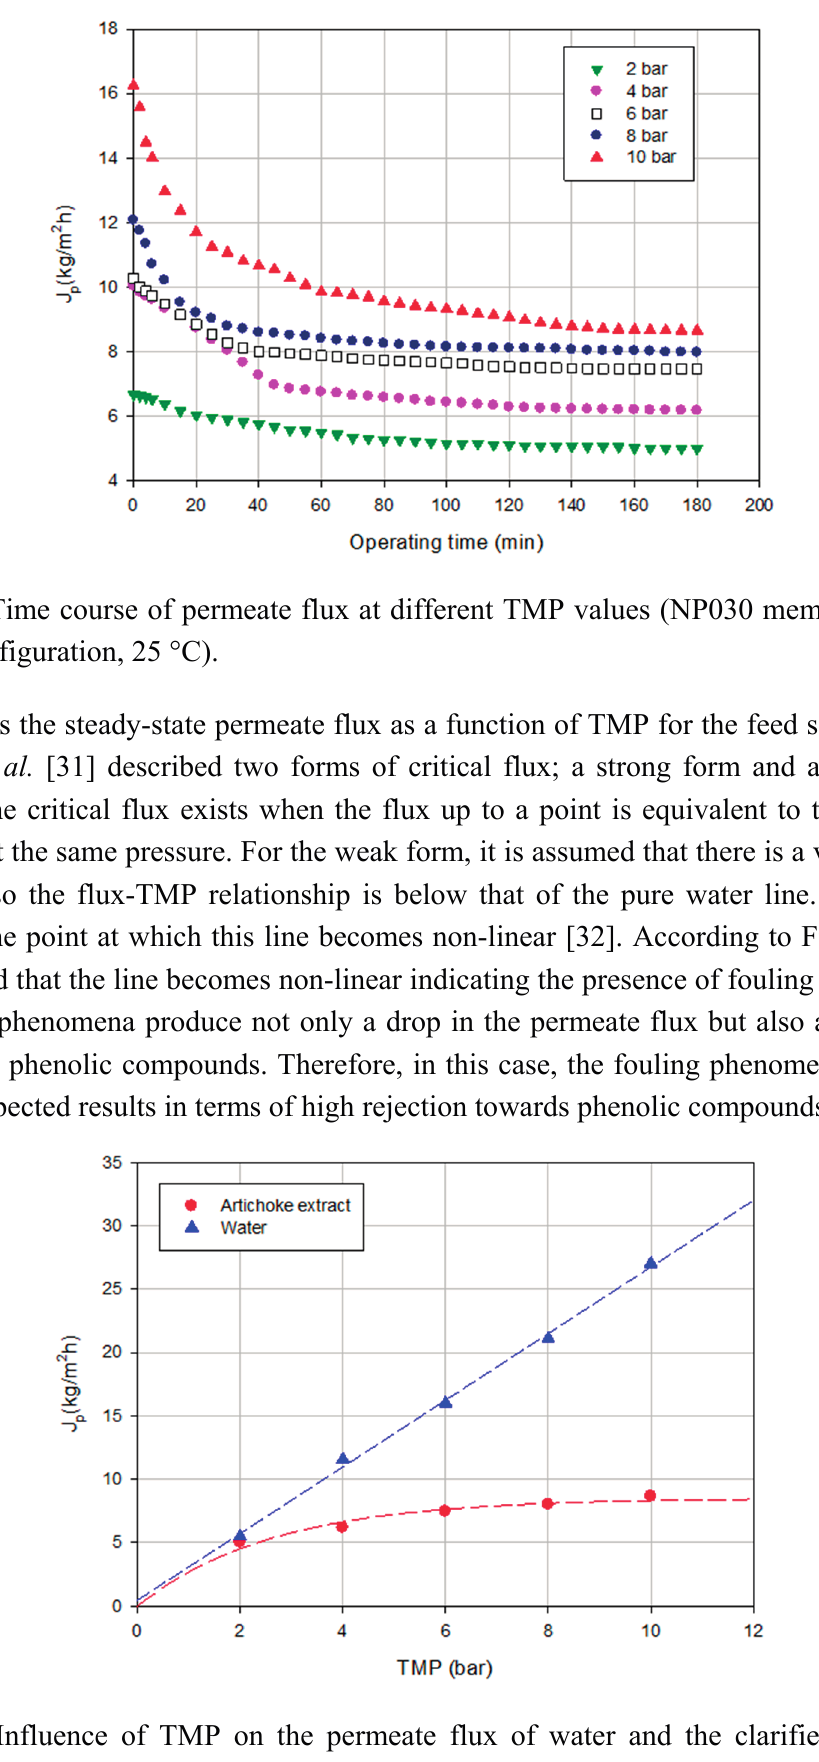
Figure 4. Influence of TMP on the permeate flux of water and the clarified artichoke extract (NP030 membrane, total recycle configuration, 25